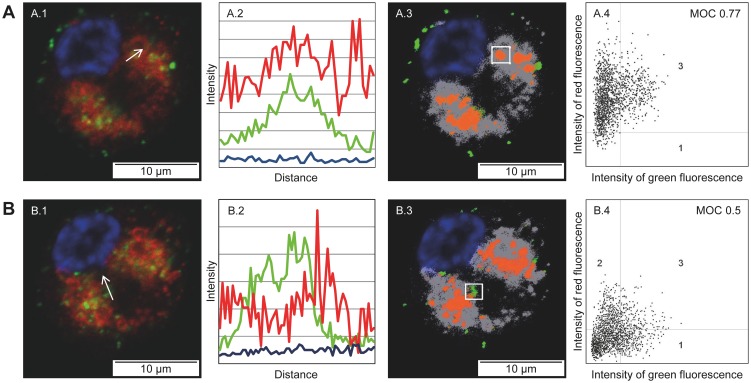
Whole virus vaccine material can be detected outside the endolysosomal compartment.Confocal LSM analysis was performed on immature DC after 4/H3N2-Uruguay whole virus vaccine. DC were pre-treated with the irreversible proteasome inhibitor epoxomicin for 4 h before vaccine was added. (A) and (B) show two different sectional planes of the same DC that was selected as a representative example of the entire sample. A.1/B.1 show LSM pictures, including nucleus (Hoechst 33342) marked in blue color, endolysosomal compartment (Lamp1/Rab5) in red color, and nucleoprotein (NP) of H3N2 in green color, respectively. (A.2/B.2) Graphs represent the fluorescence intensity of staining dyes used in A.1/B.1. White arrows in A.1/B.1 mark the measuring points from basis to arrowhead. (A.3/B.3) To further analyze the localization of NP within the DC, A.1/B.1 pictures were post-processed. Blue color means Hoechst positive only, grey color means Lamp1/Rab5 positive only, orange color means Lamp1/Rab5 as well as NP positive, green color means NP positive only. Thresholds are indicated in A.4/B.4. (A.4/B.4) Diagrams show the intensities of red (Lamp1/Rab5) and green (NP) fluorescence within white rectangles of A.3/B.3. To quantify colocalization of NP and Lamp1/Rab5 within the white rectangle of A.3/B.3 Mander's overlap coefficient (MOC) was calculated. Value range 0–1 (0: no colocalization, 1: all pixels colocalize).